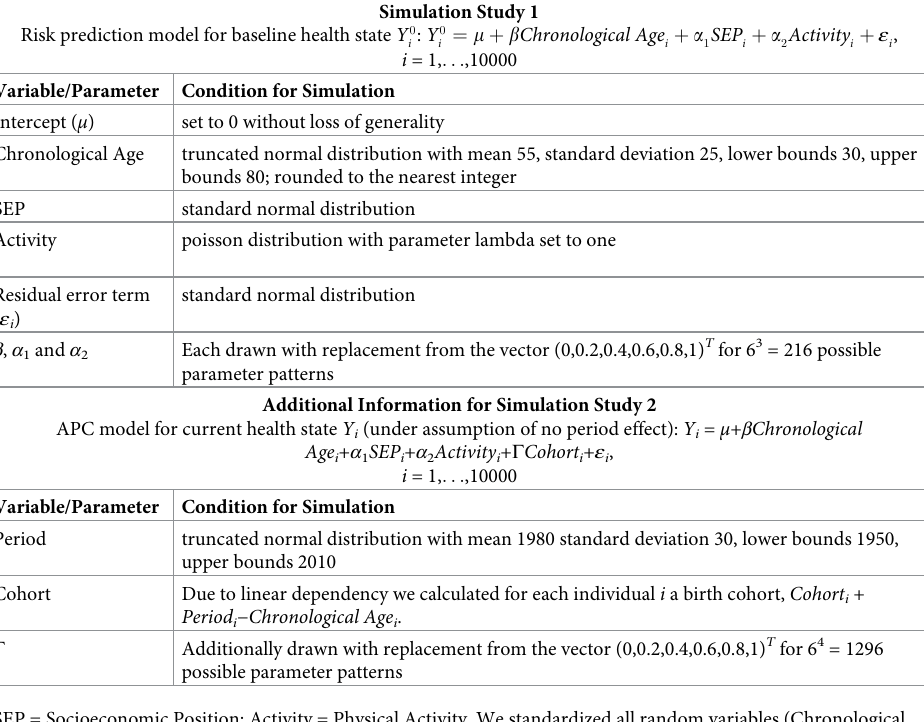
Table 1. Conditions, variables and parameters for simulation studies (N = 10 000, 1000 Monte Carlo replications of each slope parameter